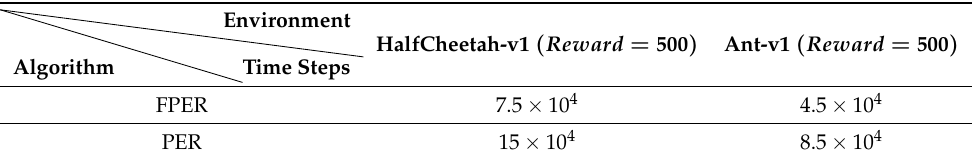
Table 2. Implemented time in continuous control